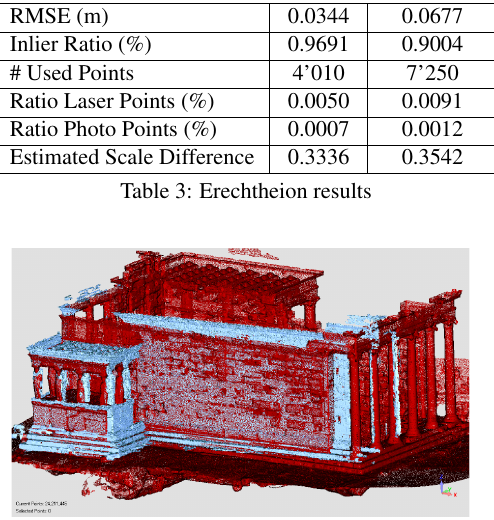
Figure 13: Erechtheion automatically registered, Red/Dark: Laser, Blue/Light: Photogrammetry